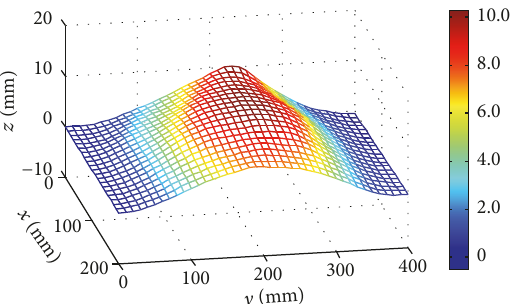
Figure 14: Controlled shape when evolution is at 320 generations.